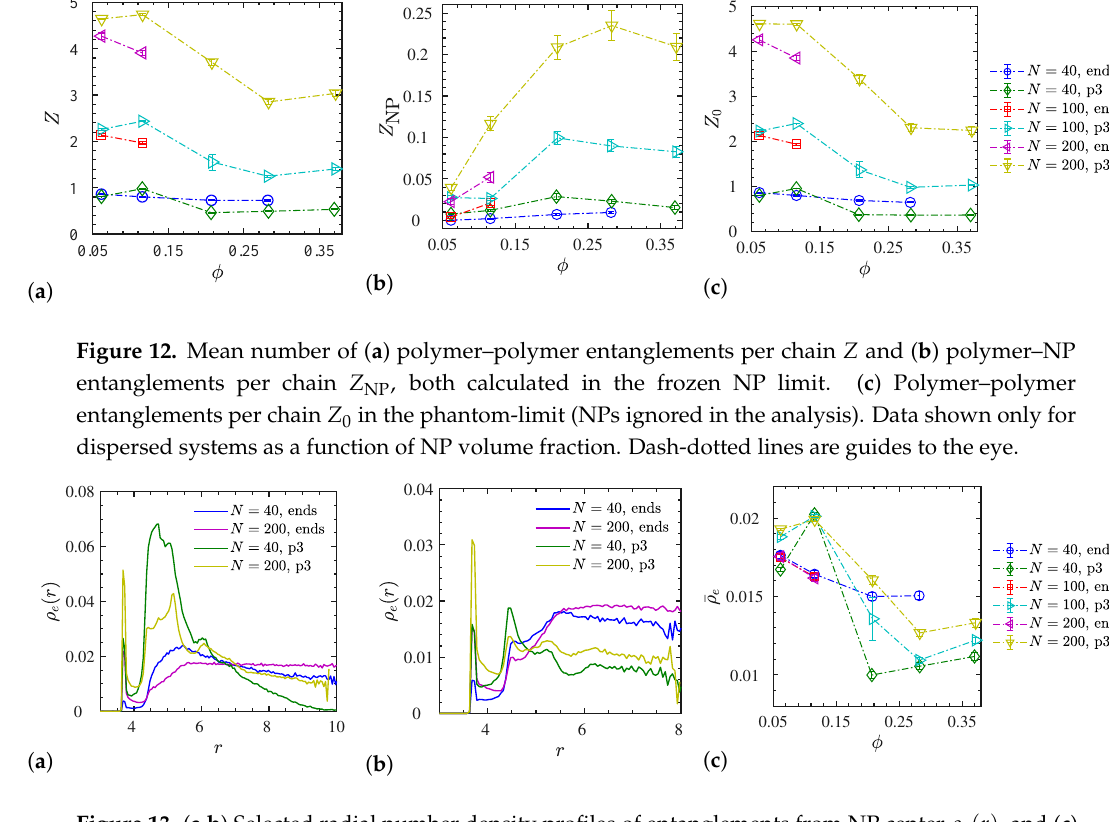
Figure 13. ( a , b ) Selected radial number density profiles of entanglements from NP center ρ e ( r ) , and ( c ) the average number density of entanglements in the system ¯ ρ e for all dispersed systems ( ε r = 24). Data in (a) corresponds to φ = 11.6% (all dispersed), and in (b) to φ = 28.3% (all dispersed except the end-charged N = 200 that had been included for comparison). For the p3-charged systems of ( a , b ) snapshots of their entanglement networks are available in Figure 11 and Supplementary Figure S15,